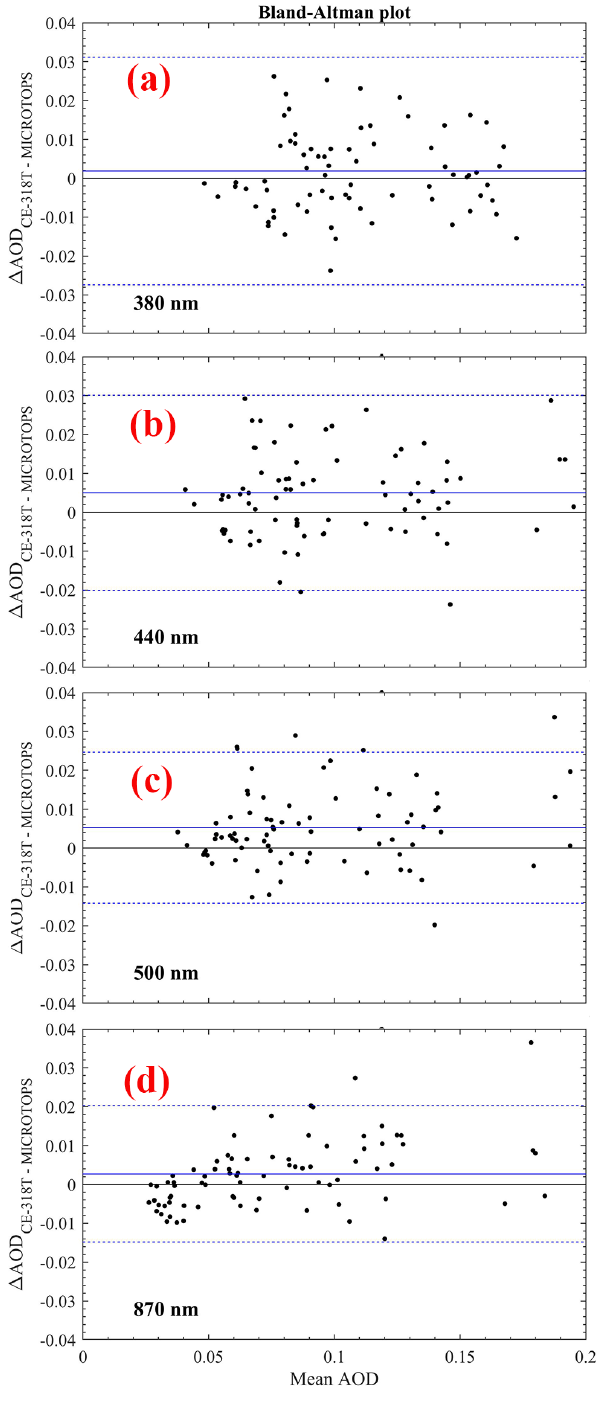
Figure 5. Bland–Altman plots for AOD differences with mean AOD ((AOD CE − 318T + AOD MICROTOPS )/2) at 380 (a) , 440 (b) , 500 (c) and 870nm (d) . The solid black-colored and blue-colored lines rep- resent the zero line and the mean AOD differences, respectively. Dotted blue-colored lines represent the mean AOD plus/minus the root-mean-squared AOD